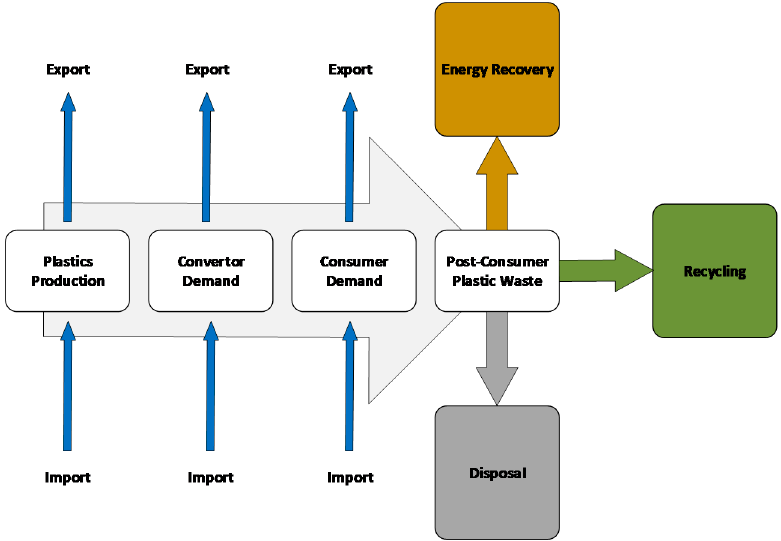
Figure 7. Solutions for the polypropylene waste management in the end-of-life stage.